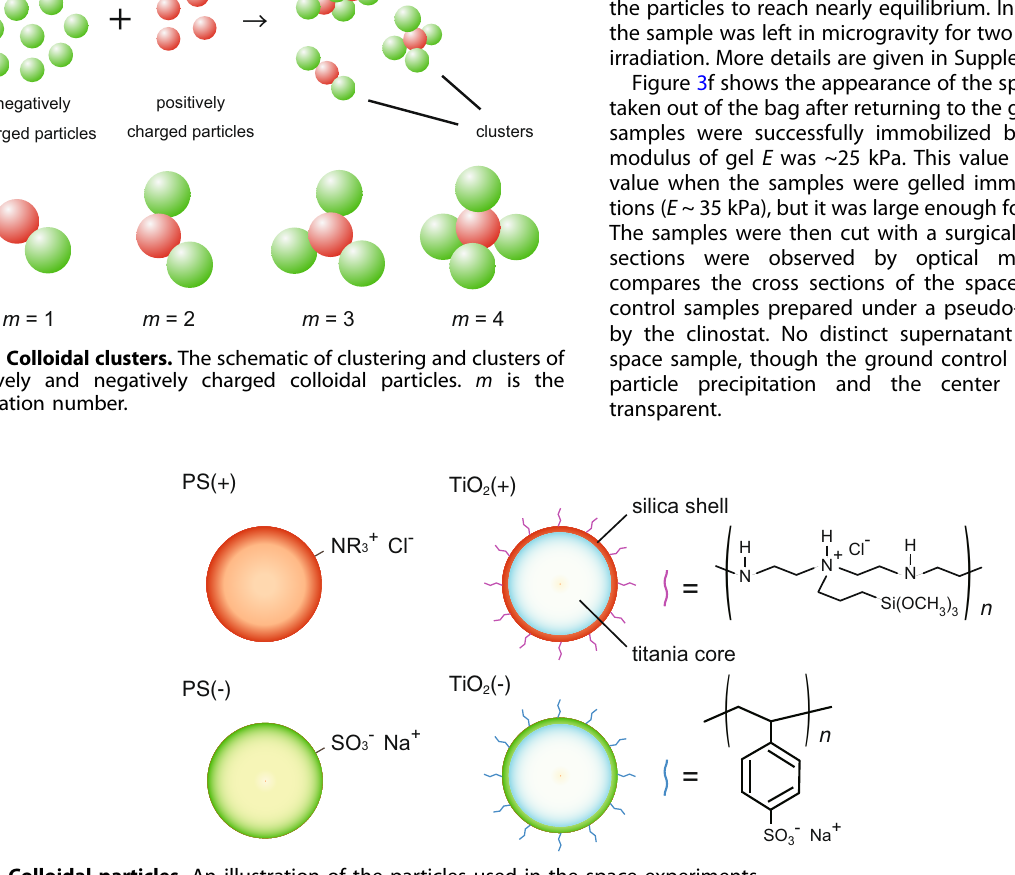
Fig. 2 Colloidal particles. An illustration of the particles used in the space